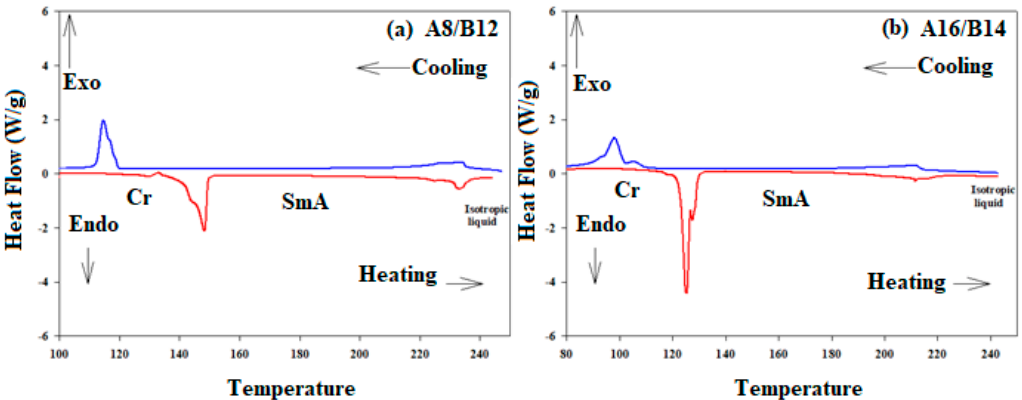
Figure 2. Differential scanning calorimetry (DSC) curves upon the second heating/cooling cycles with rate of 10 °C/min for 1:1 SMHBCs ( a ) A8 / B12 and ( b ) A16 / B14 .